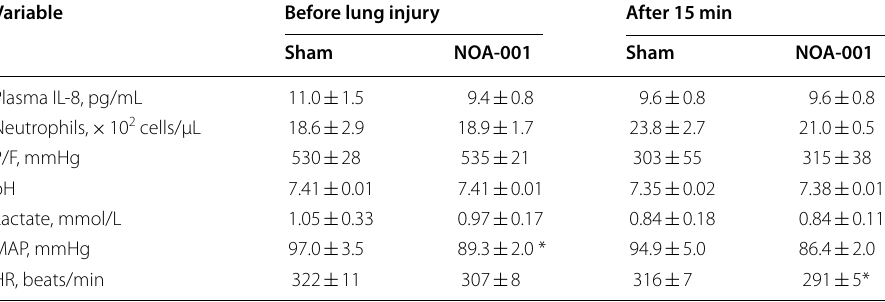
* p < 0.05 for sham vs. NOA-001 groups by Mann–Whitney U test